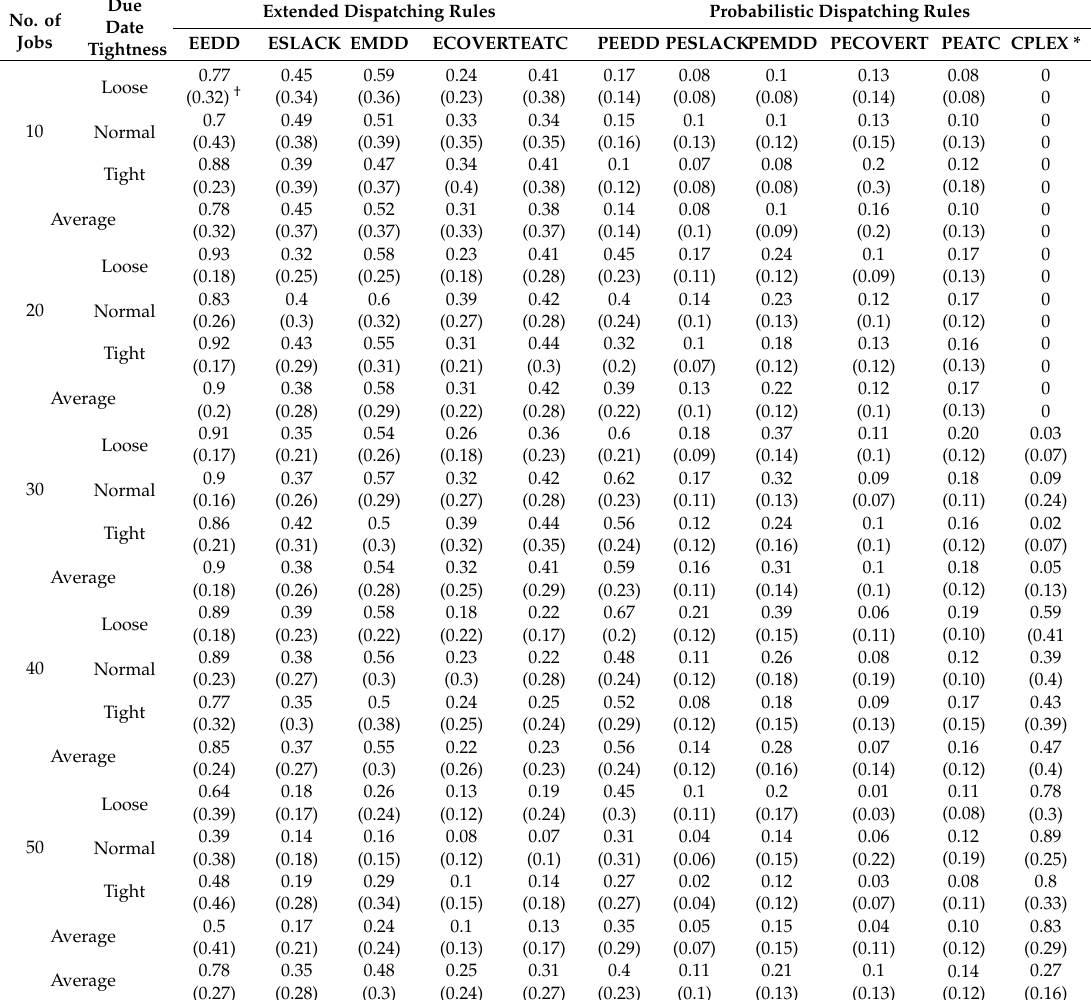
Table 4. Comparison of RDI values between extended dispatching rules and their probabilistic versions.